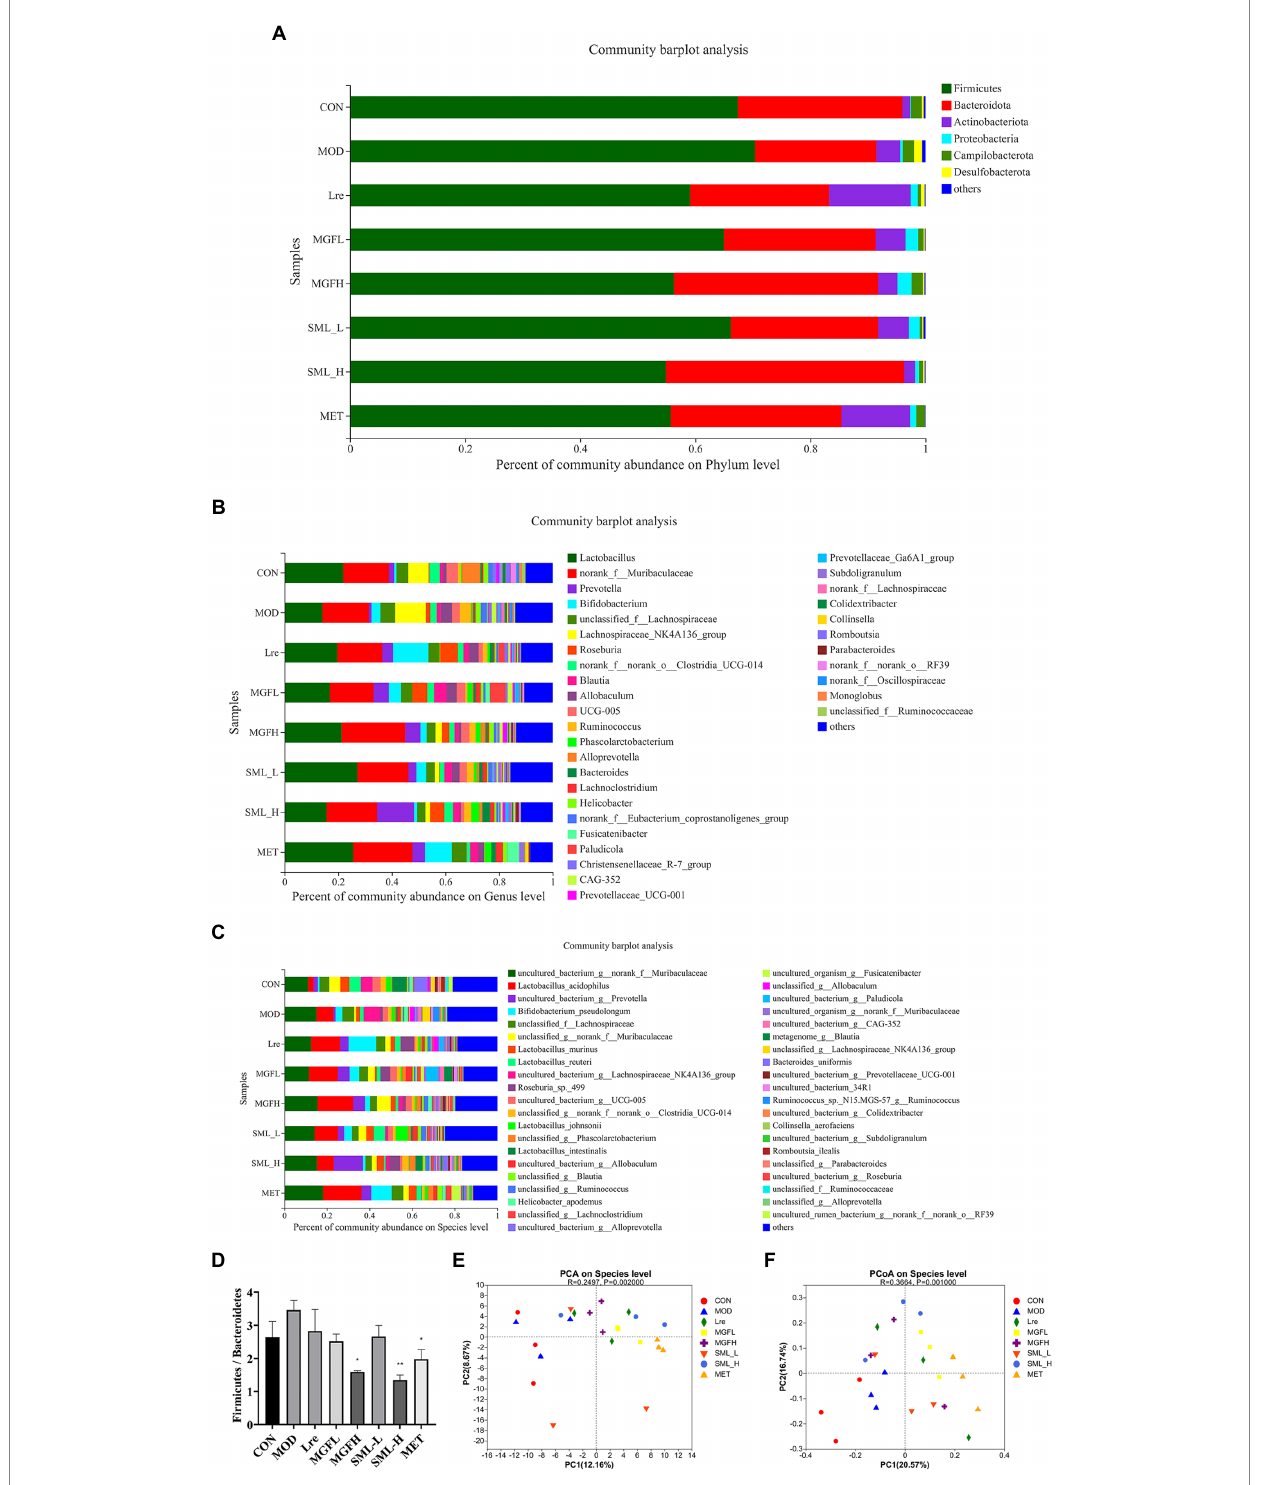
FIGURE 4 Composition of intestinal flora. (A–C) , respectively, showed intestinal flora relative proportion at phylum, genus, and species levels. (D) was the proportion of Firmicutes/Bacteroidetes. (E,F) were PCA and PCoA, respectively. The distance between points indicated the correlation between samples. * p < 0.05, ** p < 0.01 compared with the